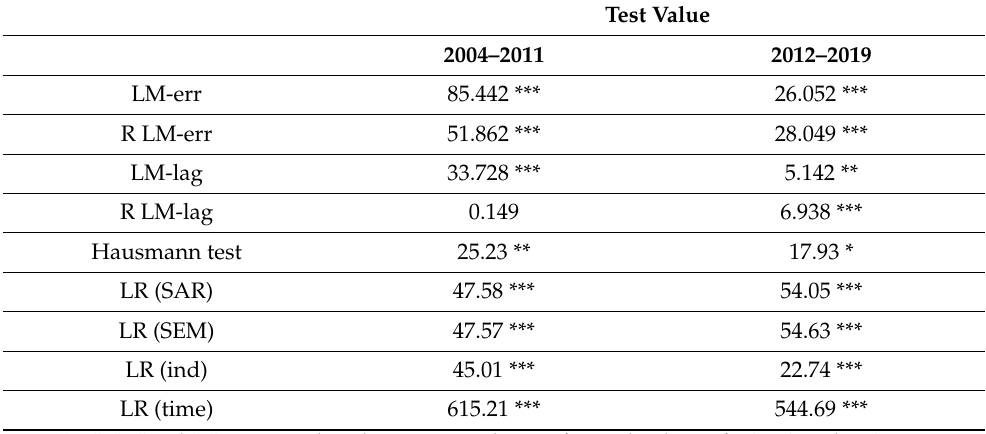
Table 4. Model selection